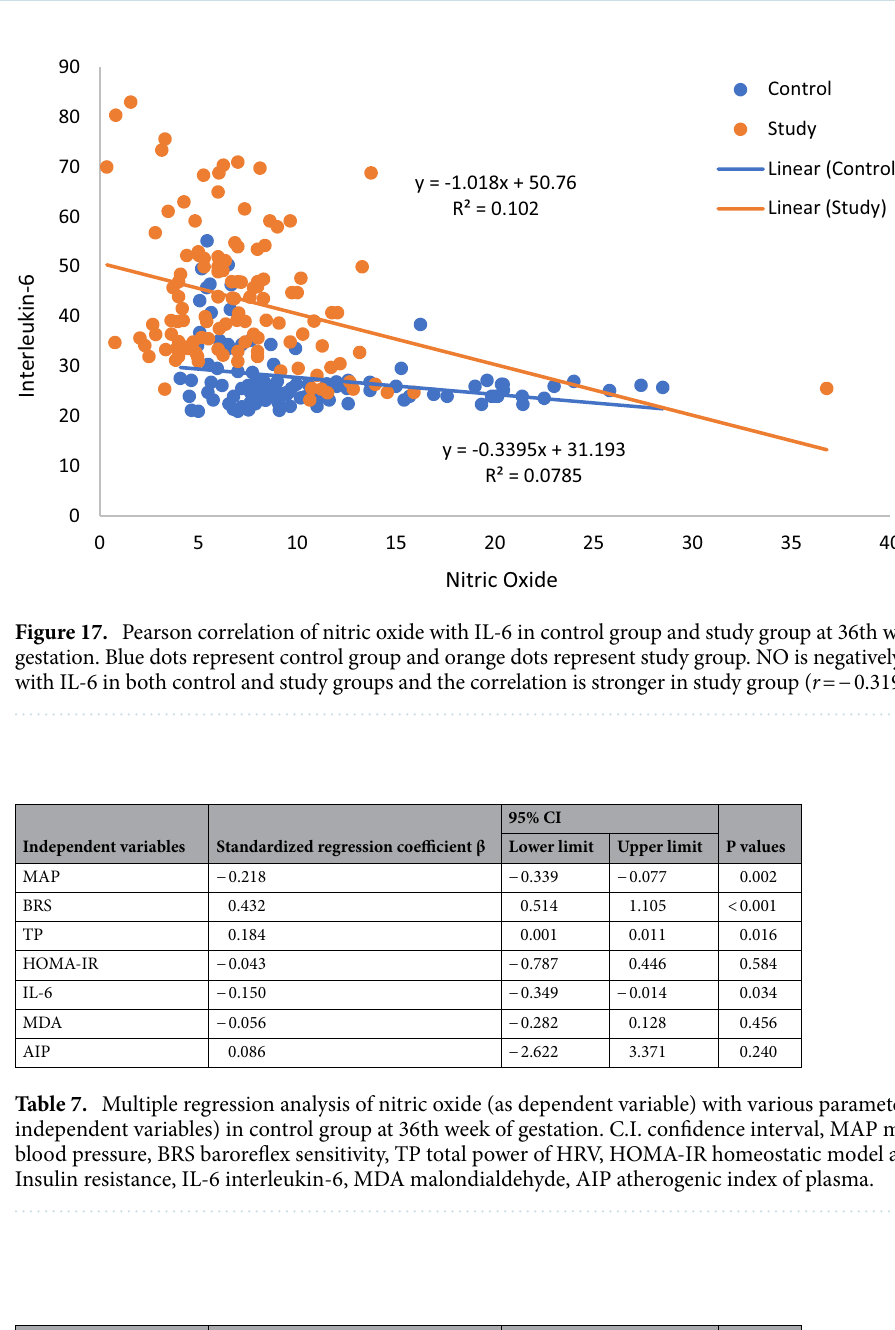
Independent variables Standardized regression coefficient β